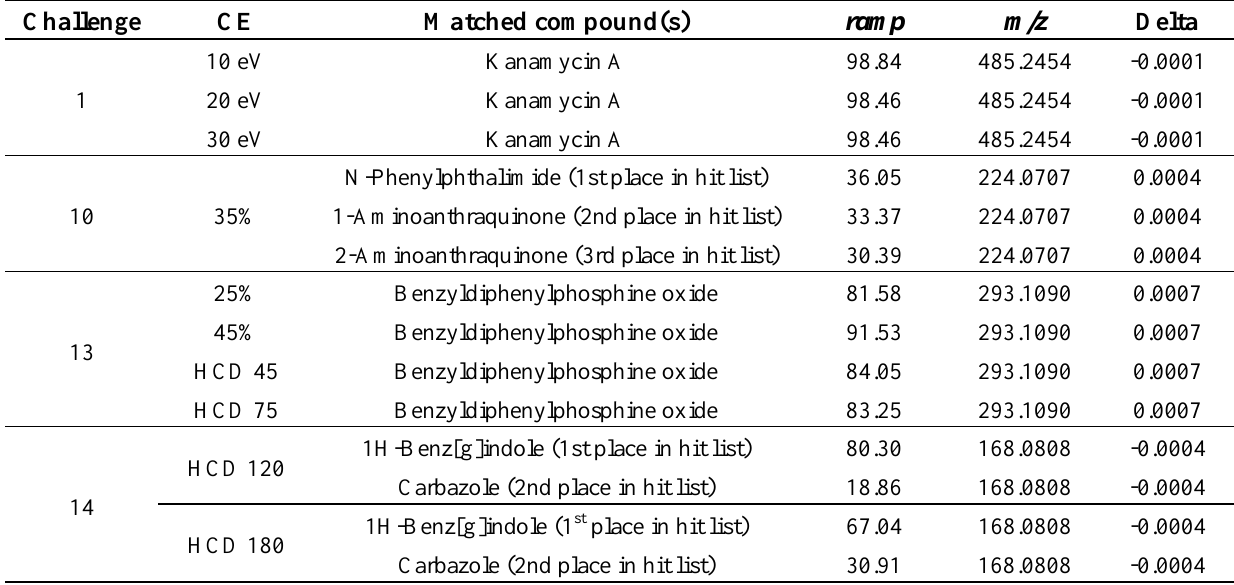
Table 5. Putative identifications with the extended Wiley Registry MS/MS. Unless otherwise stated, information on the best matching compound only is